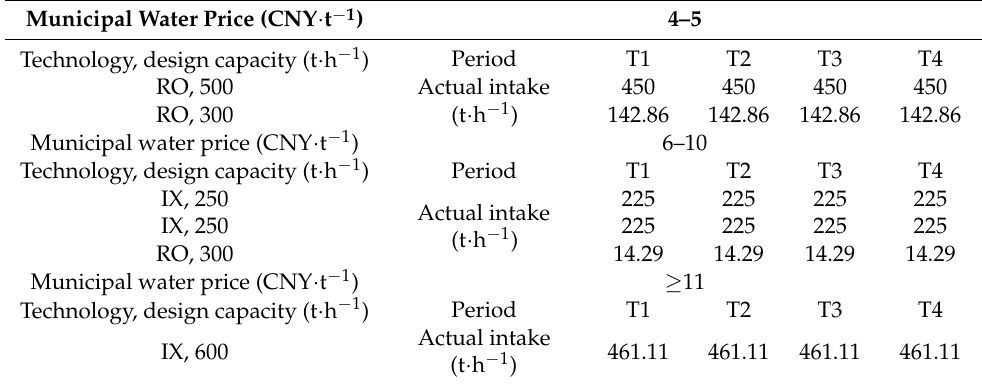
Table 5. Optimal operation scheme under different water price (Scenario